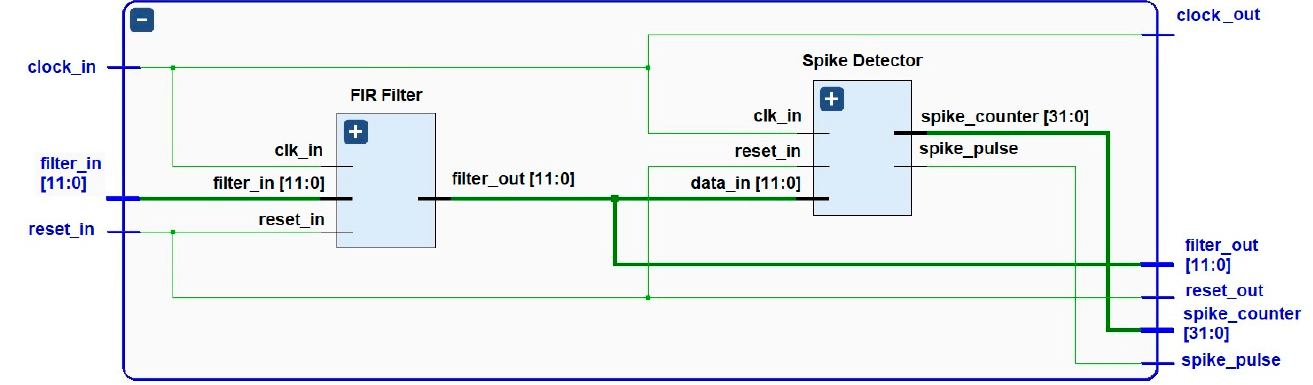
Figure 2. Schematic diagram of filtering and spike detection set.